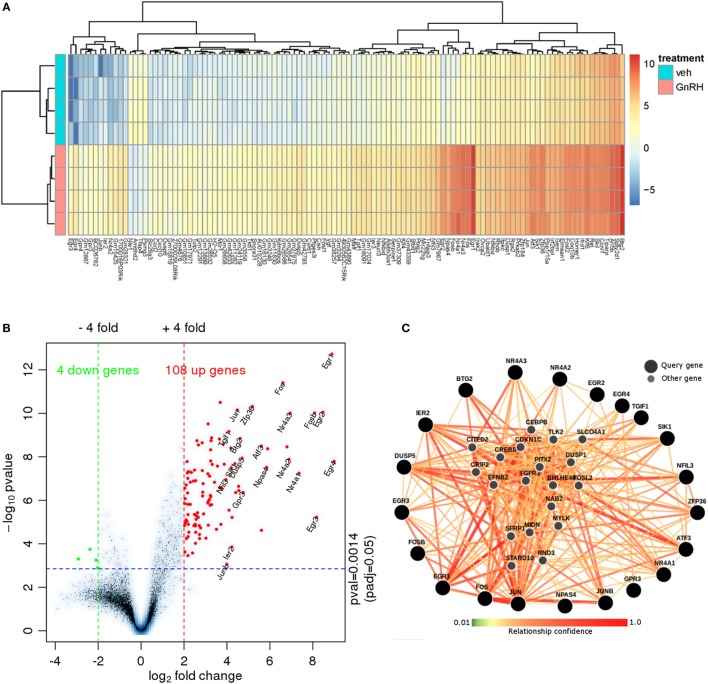
RNA-seq data analysis. (A) Heat map of RNA-seq expression data showing the genes that were differentially regulated following treatment with 5 nM gonadotropin-releasing hormone (GnRH) for 45 min. Gene expression is shown in normalized log2 counts per million. Differentially expressed genes were selected based on a fourfold change and FDR < 0.05. (B) Volcano plot with the log2 fold changes in gene expression after GnRH treatment on the x-axis and the statistical significance (−log10 p value) on the y-axis. The gene symbols of 21 annotated genes with at least a 16-fold expression change are displayed. (C) Functional network analysis of the top 21 genes using (Genome-scale Integrated Analysis of gene Networks in Tissues) (39). Nodes related to those 21 genes are shown (smaller markers) in this human hypophysis (pituitary) data-driven Bayesian functional network.